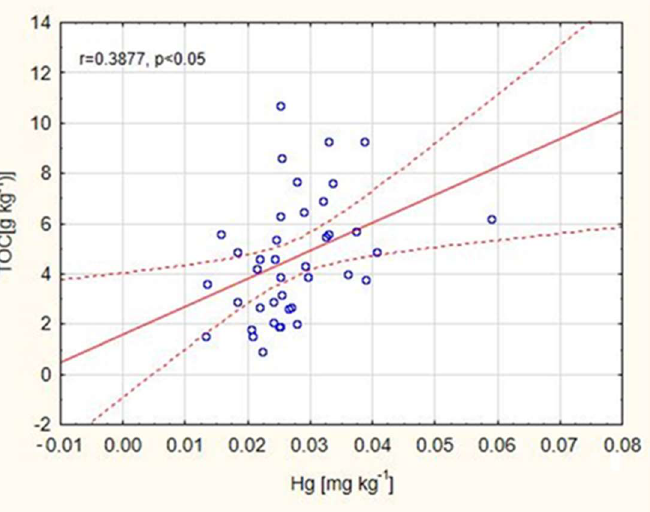
Figure 2. Correlation with a significant relationship between the TOC content and the total content of mercury. of Table 3. Statistical parameters.